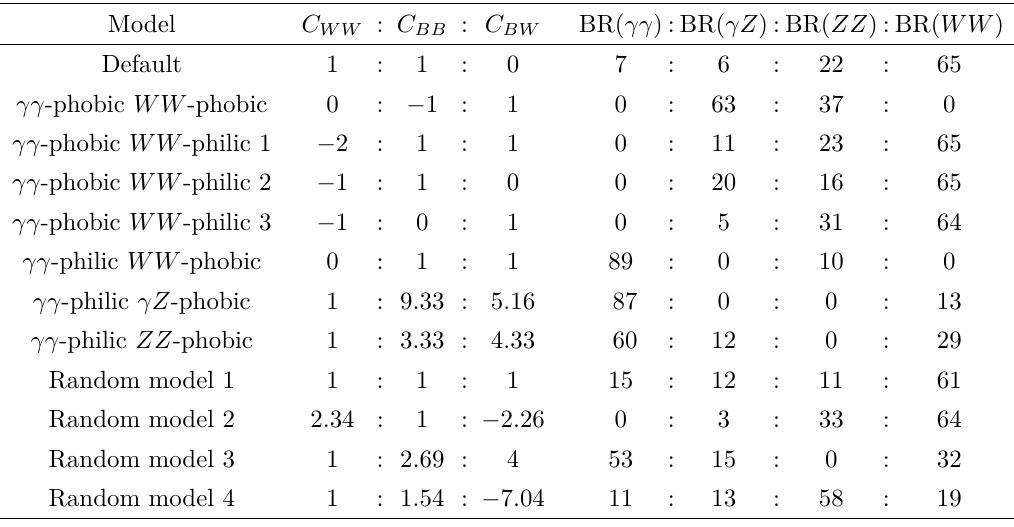
Table 3 . Details of ALP models in the model independence test. The branching fractions are normalized to percentages for readers’